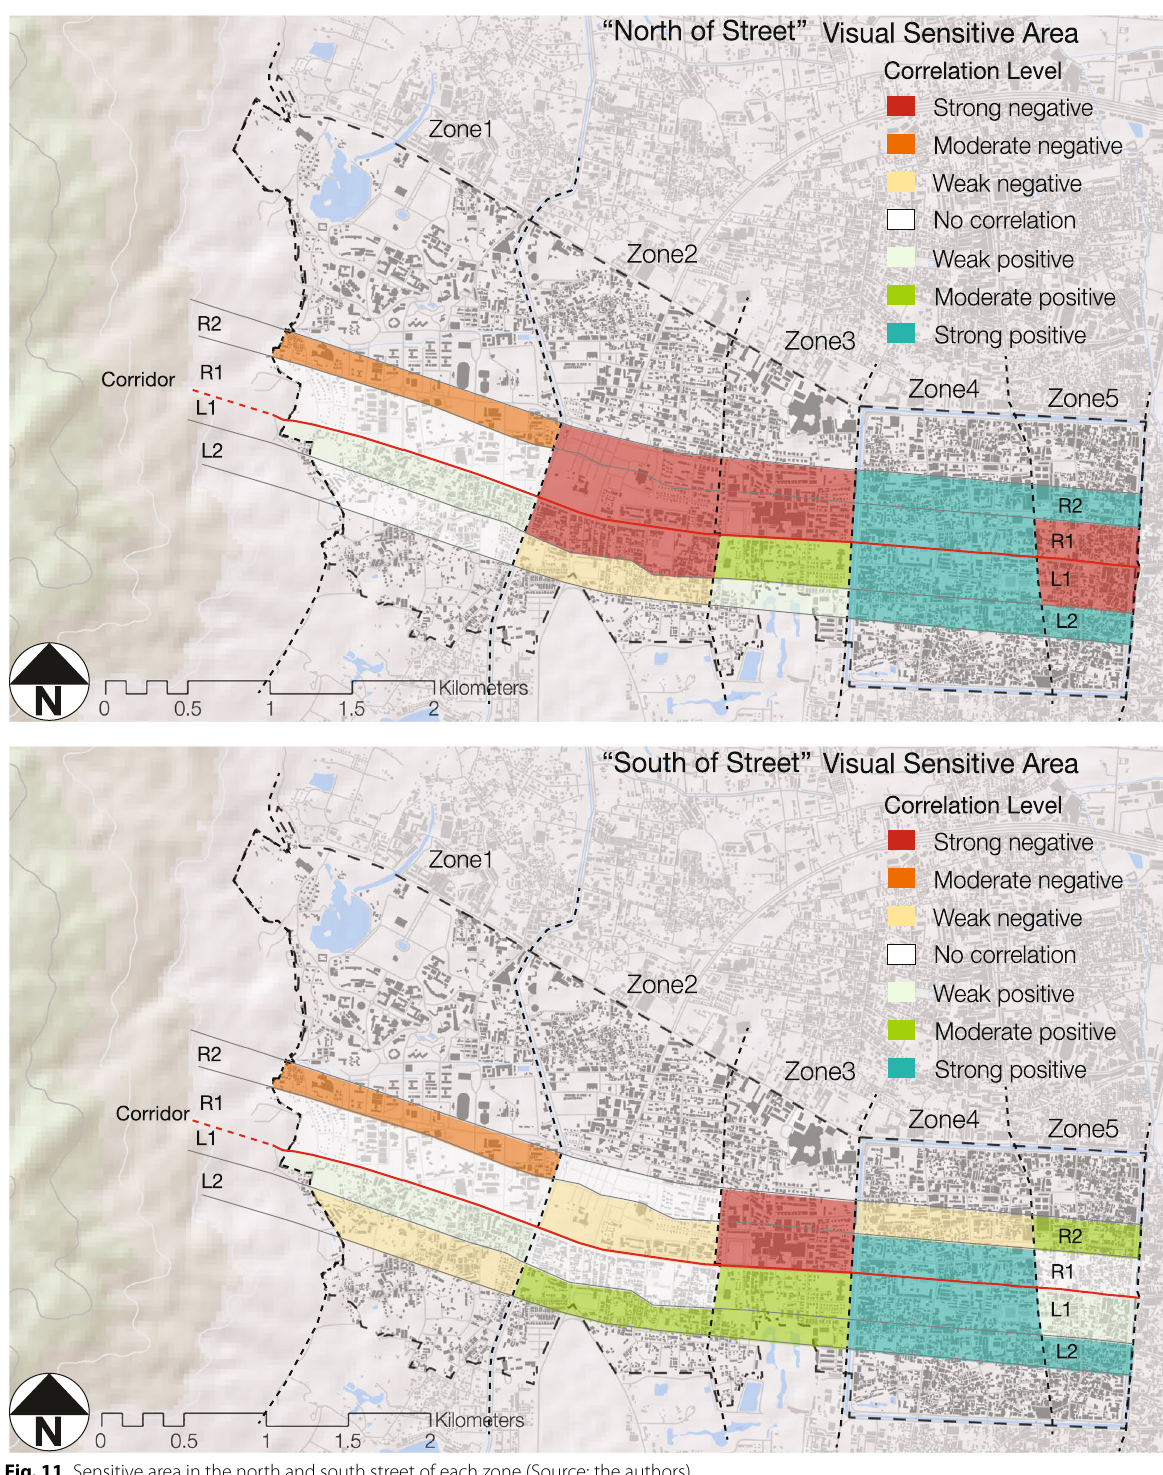
Fig. 11 Sensitive area in the north and south street of each zone (Source: the